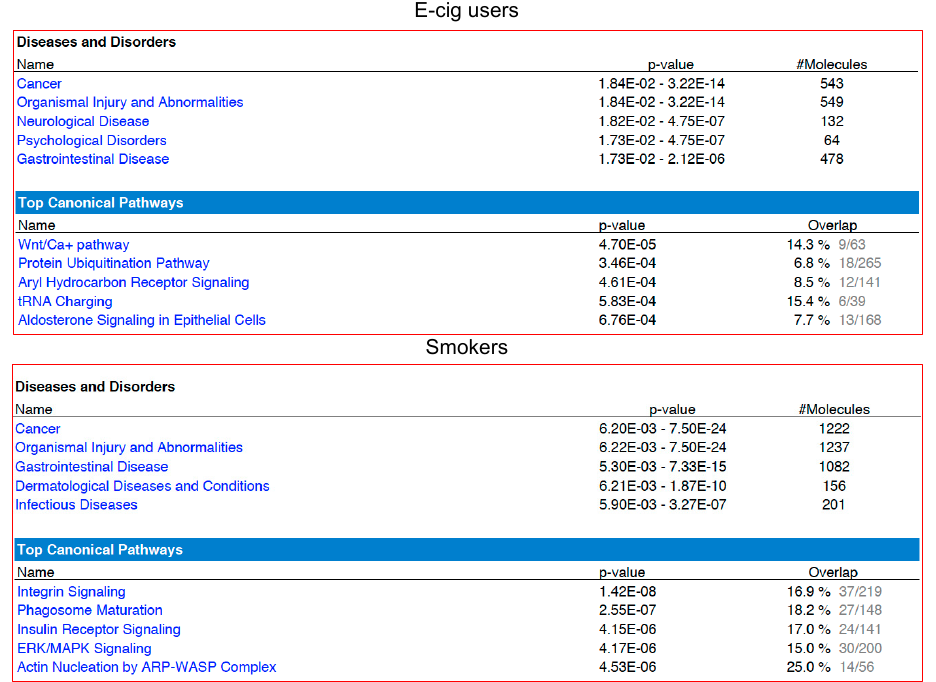
Figure 2. Functional pathway analysis of differentially expressed genes in e-cig users and smokers relative to controls by IPA ® . In both groups, differentially expressed genes are predominantly associated with “cancer”. The “Wnt/Ca + pathway” in e-cig users and the “integrin signaling pathway” in smokers are the most affected pathways.